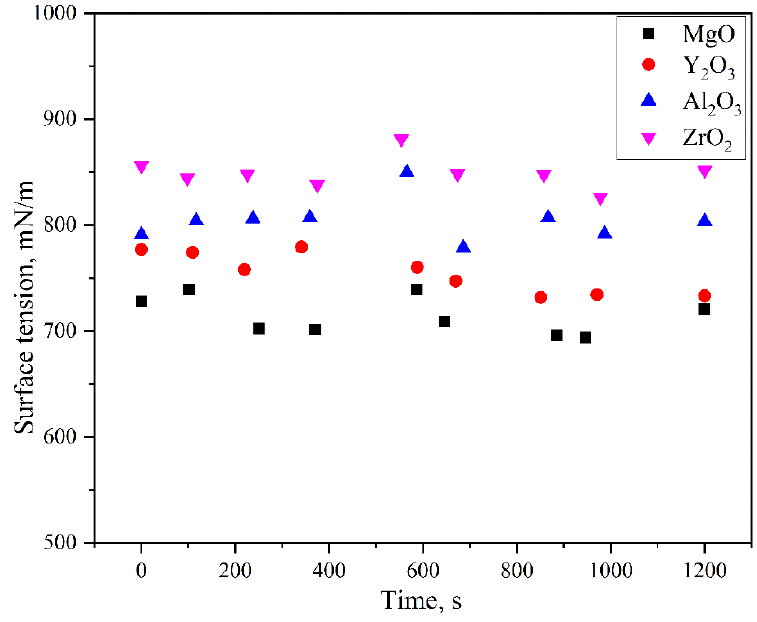
Figure 10. Variation in the surface tension with time with regard to the wetting of the molten alloys on the different substrates at 1873 K.